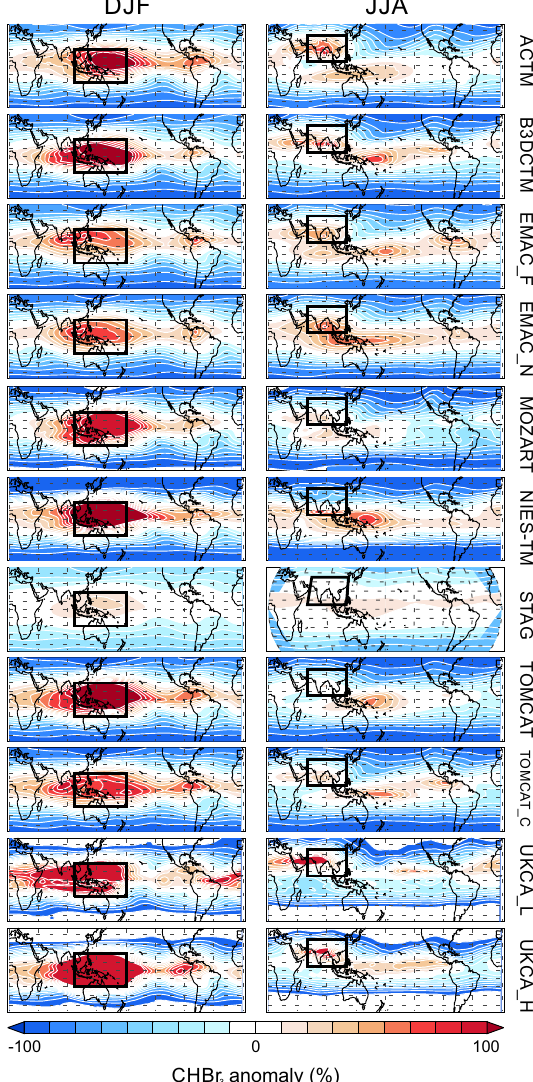
Figure 14. Simulated anomalies of the CHBr 3 volume mixing ratio with respect to the tropical ( ± 30 ◦ latitude) mean (expressed in %) at 100hPa for (a) boreal winter (DJF) and (b) boreal summer (JJA). The boxes highlight the tropical western Pacific and location of the Asian monsoon – regions experiencing strong